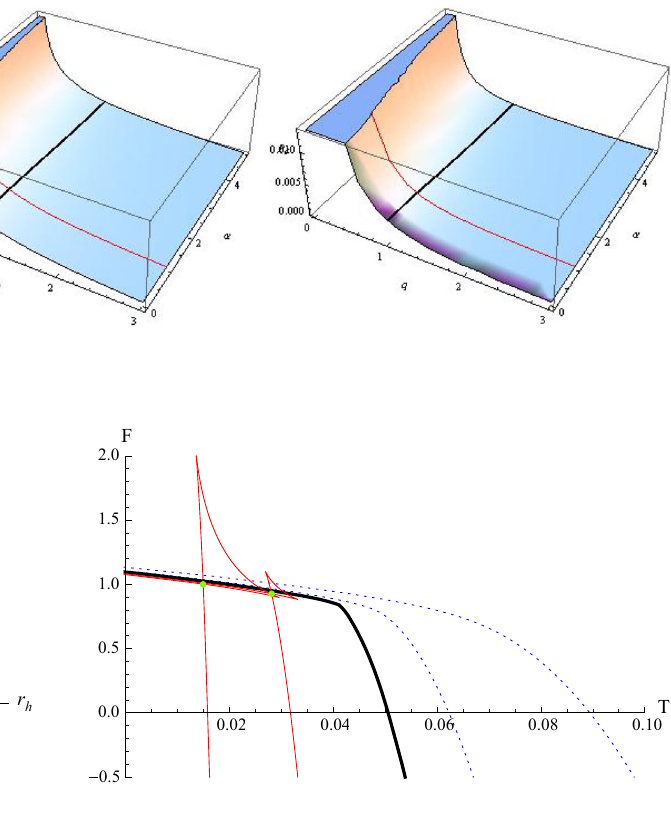
Fig. 3 Gibbs free energy and the temperature. The solid black line is for the critical pressure P c = 0 . 002943 while the dotted blue lines and solid red lines are for P > P c and P < P c , respectively. We set q = α = 1